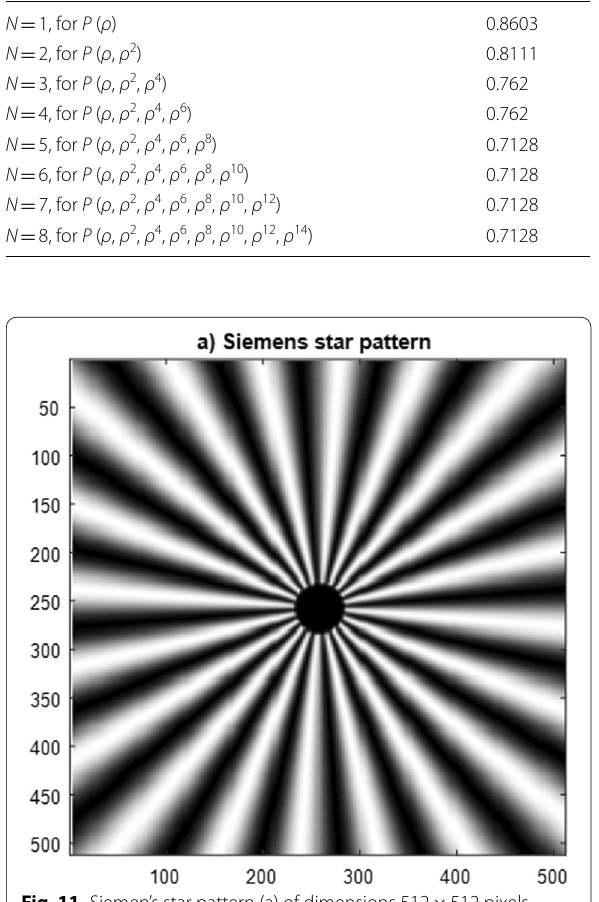
Fig. 11 Siemen’s star pattern (a) of dimensions 512 used as an object in the CSLM provided with the second model of polynomial aperture